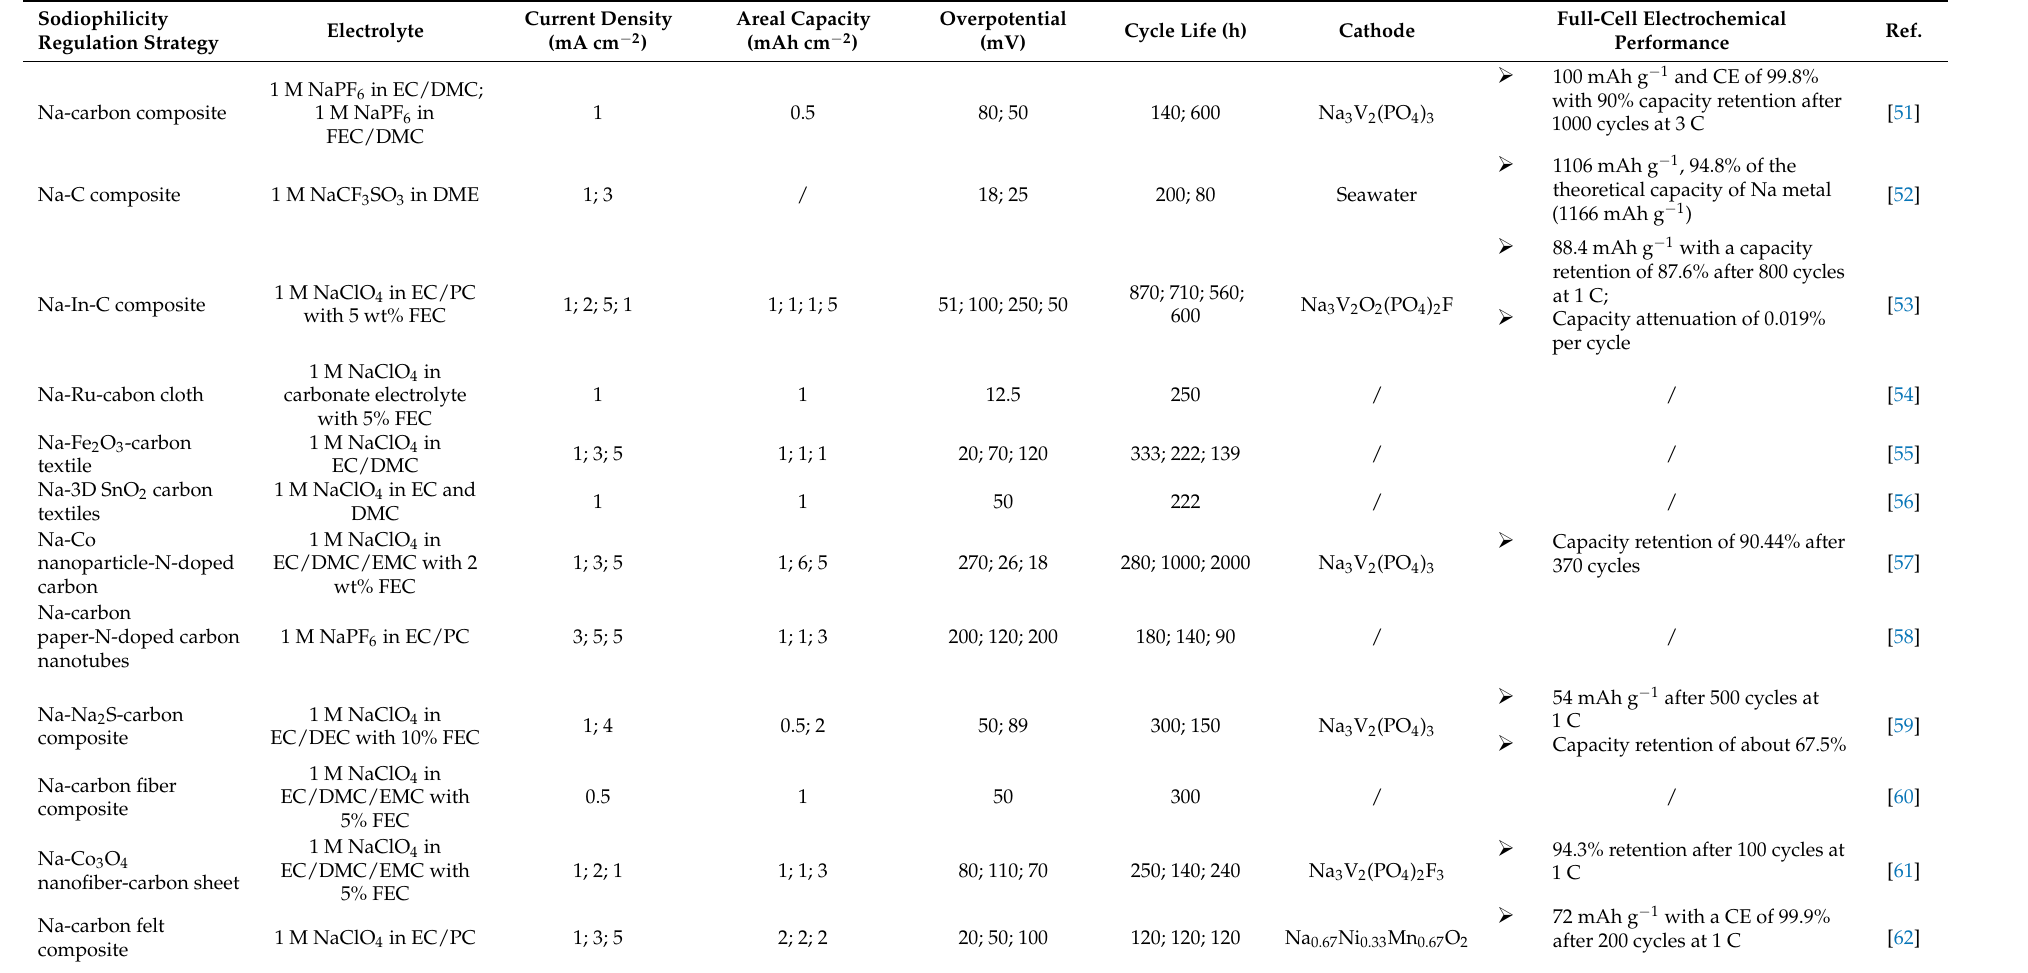
Table 2. Comparison of electrochemical performance of Na metal anodes modified by different wettability-enhancing strategies.